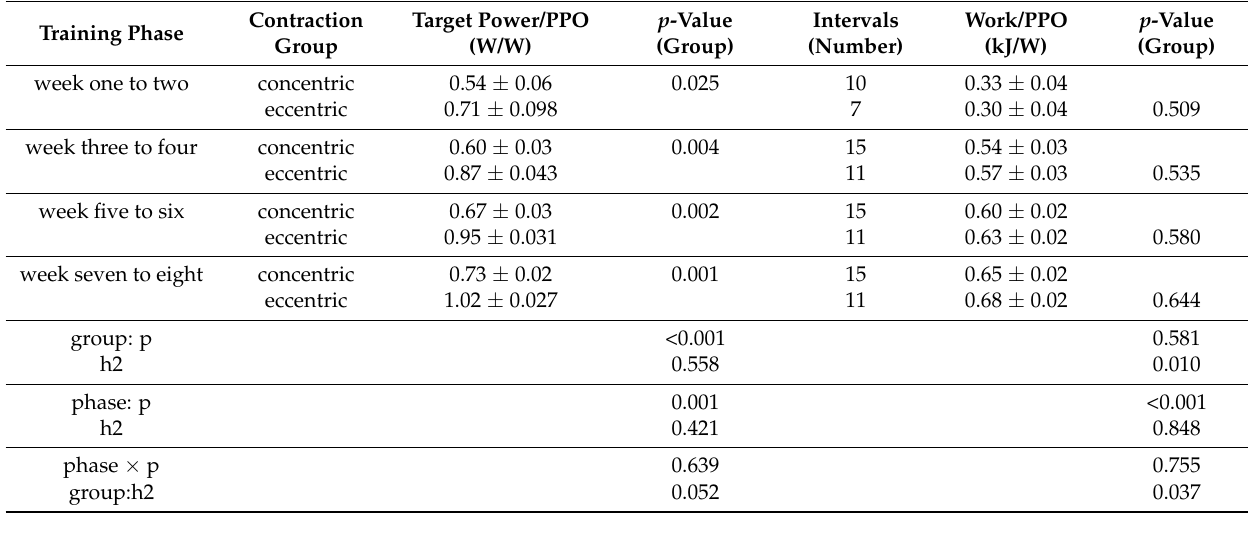
Table 1. Target workload during interval pedaling exercise. Mean ± standard error (SE) of the peak aerobic power output (PPO)-related target power, intervals, and PPO-related work to be performed by the group of subjects in the four phases of interval-type training under the concentric or eccentric contraction protocol. ANOVA with post-hoc test for the least significant difference.